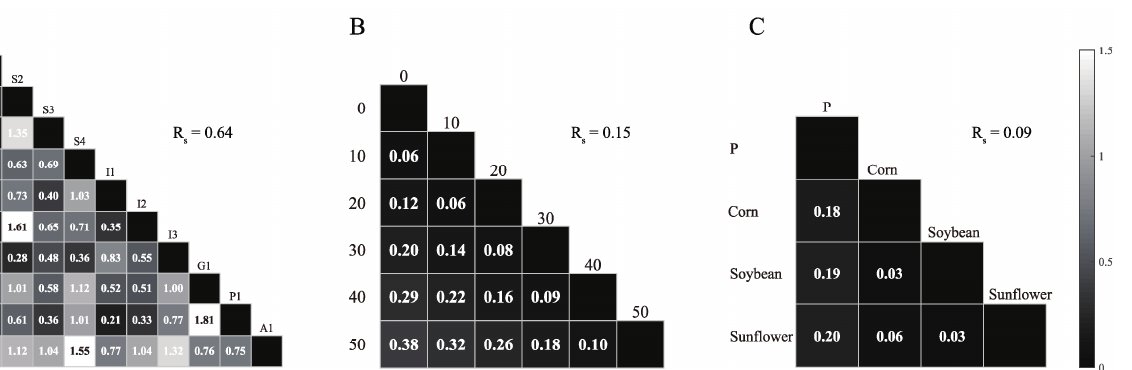
Figure 4. ANOVA-PDR mapping of the three main factors. ( A ) EVOO Origin; ( B ) Adulteration Level; ( C ) Adulteration Type. R s , geometric average of all PDR scores.